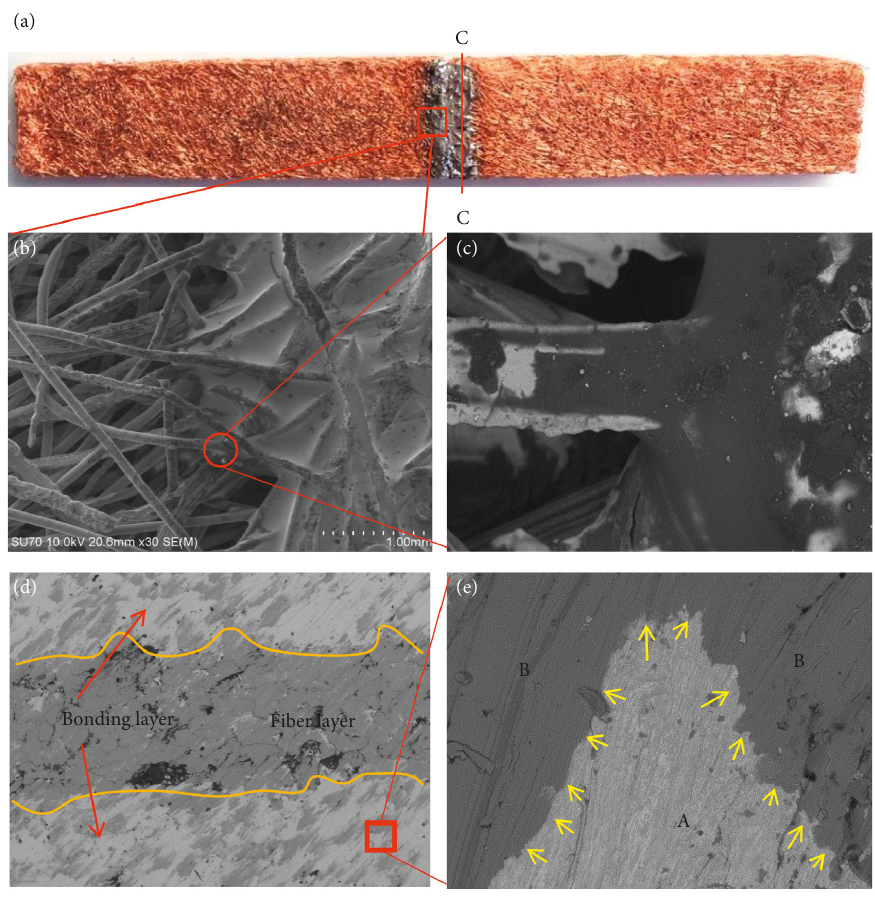
Figure 5: Appearance of soldered PCFSSs and surface morphology of the soldering joint.